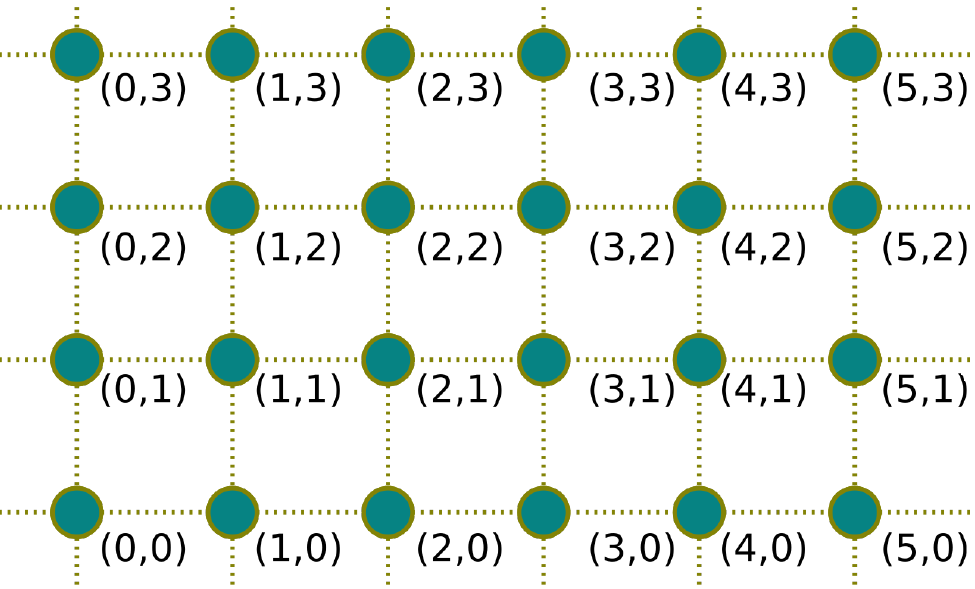
Figure 2. Representation of the grid structure showing both the ISL links and the satellite